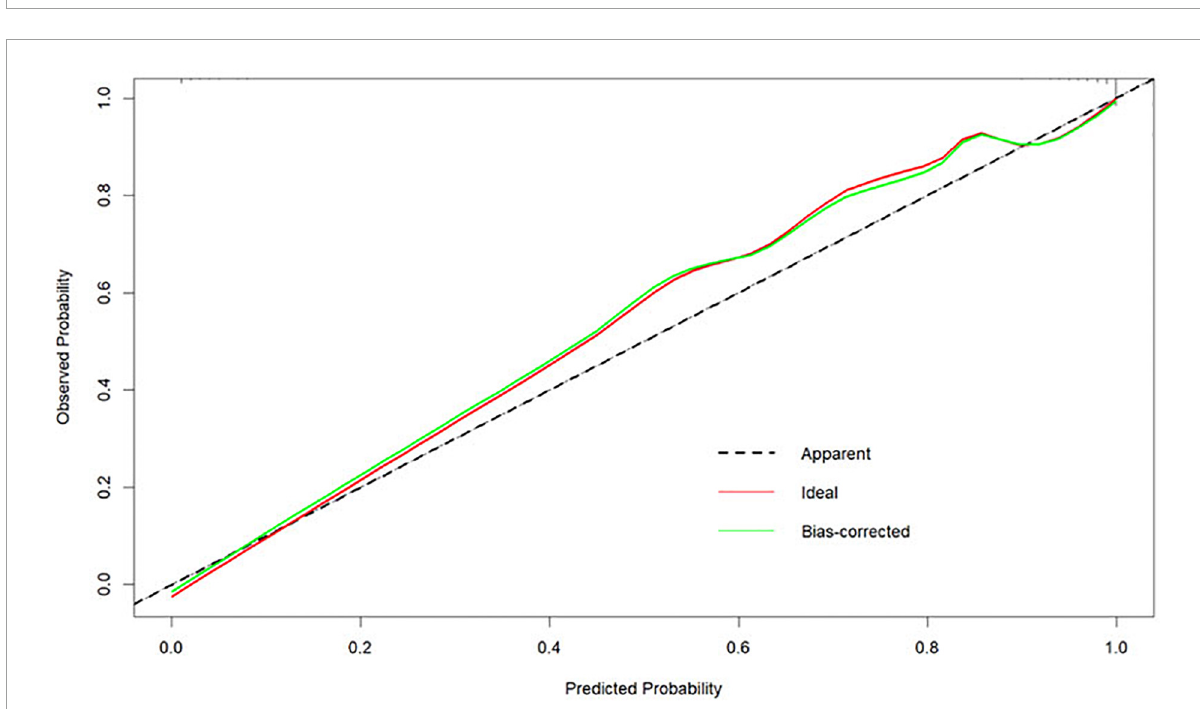
FIGURE6 Calibration curves for the nomogram model predicting the risk of developing moderate-to-severe OSA.